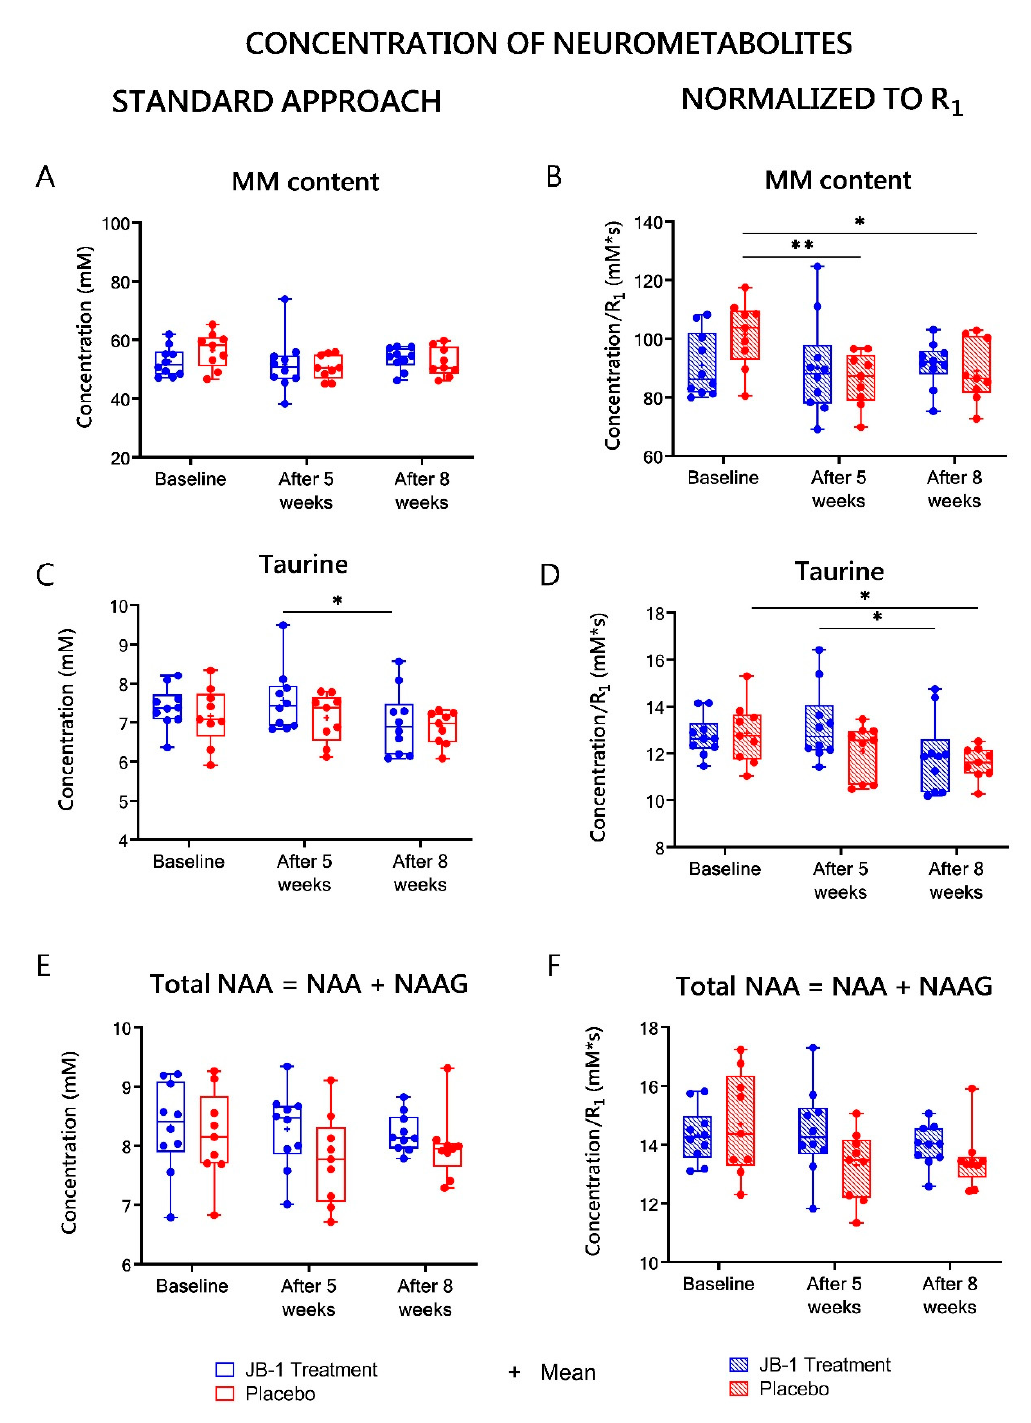
Figure 5. Hippocampal MM content ( A ), taurine ( C ), tNAA ( E ) levels calculated using typical water referencing (standard approach)—left column. Hippocampal MM content ( B ), taurine ( D ), tNAA ( F ) levels normalized to R 1 —right column. Neurometabolites’ concentrations were assessed by MRS in JB-1 treatment and placebo groups at baseline and after five and eight weeks stress protocol. Data are presented as median ± min/max. * p < 0.05; ** p < 0.01, two-way ANOVA analysis for repeated measures with post-hoc Duncan’s test.